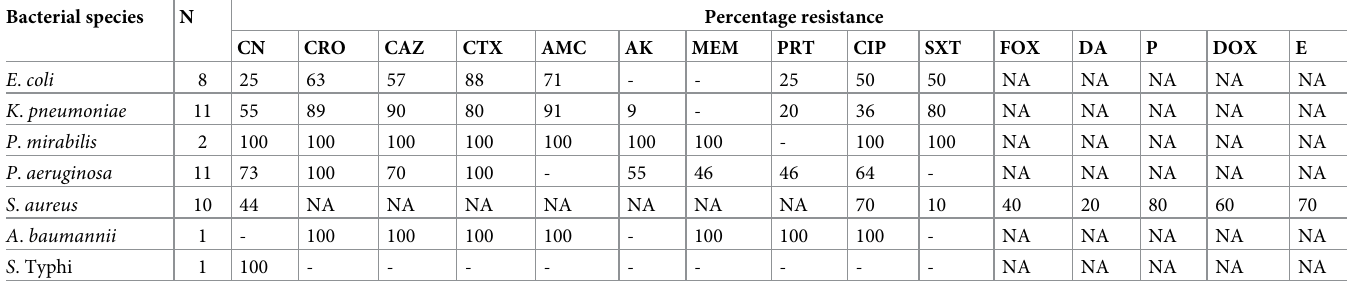
Table 3. Antimicrobial resistance pattern of bacteria isolated from patients with BSI at MNH. Bacterial species